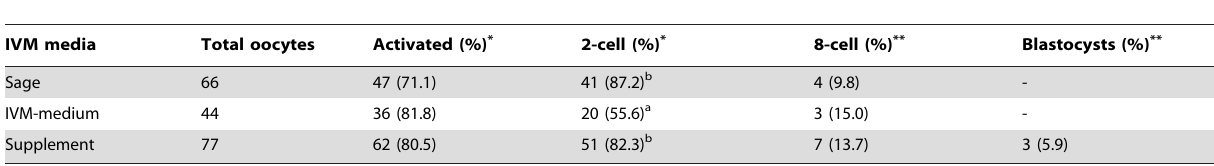
Sage: commercial IVM medium supplemented with FSH, hCG and estradiol. IVM-medium: IVM-medium supplemented with 10% SPS. Supplement: IVM-medium supplemented with BDNF, estradiol, IGF-I, GDNF, FGF2, leptin. *Percentage from activated oocytes. **Percentage from cleaved embryos. a,b Within columns, values with different superscripts were significantly different (P , 0.05).